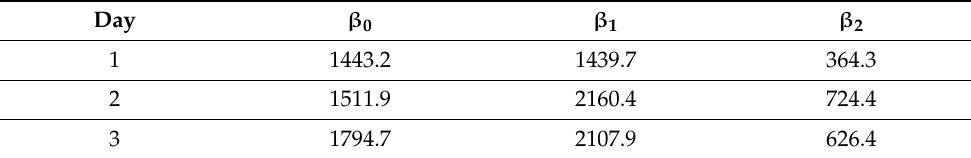
Table 1. Estimates of the regression coefficients for thrombin prediction in the standards as a function of optical density (OD) reads in each of the three